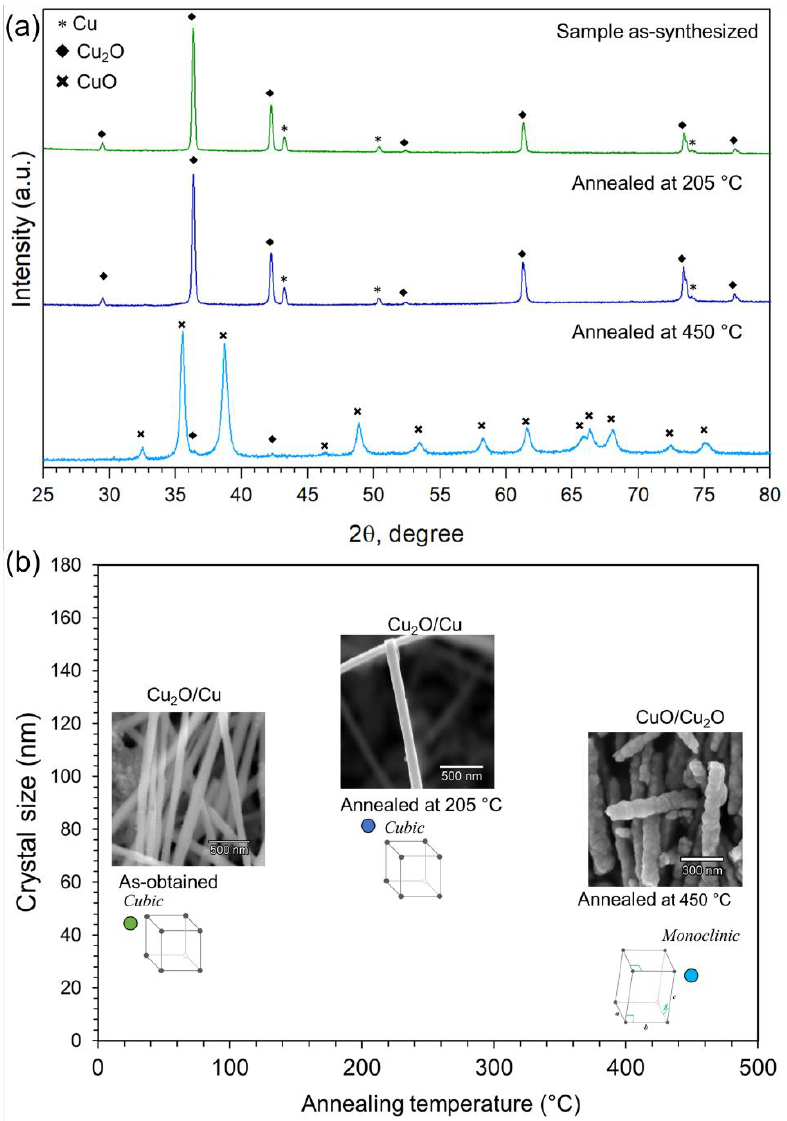
Figure 3. ( a ) XRD diffractogram for the copper oxide nanowires as-obtained (green circle), annealed at 205 °C (dark blue circle) and at 450 °C (light blue circle), ( b ) change of crystal size, phase, and at 205 ◦ C (dark blue circle) and at 450 ◦ C (light blue circle), ( b ) change of crystal size, phase, and nanowire morphology with annealing temperature. nanowire morphology with annealing